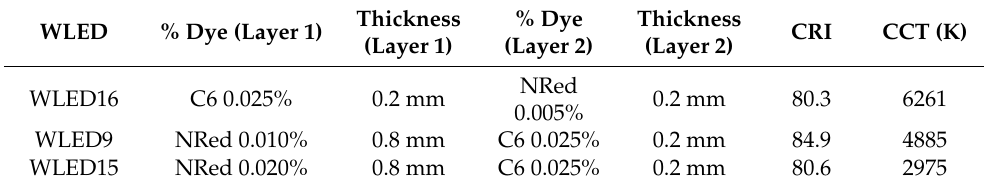
Table 4. Description of three selected WLED devices (16, 9, and 15) along with their optical properties.